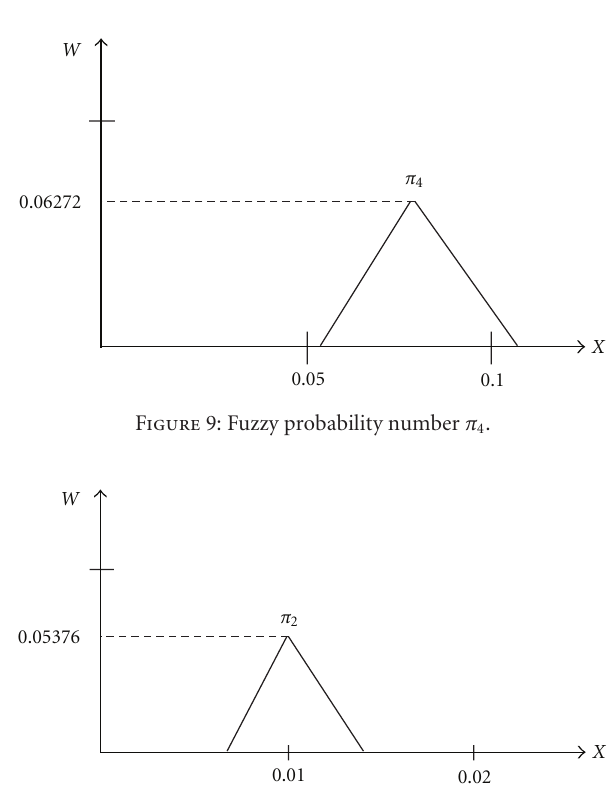
Figure 10: Fuzzy probability number π 2